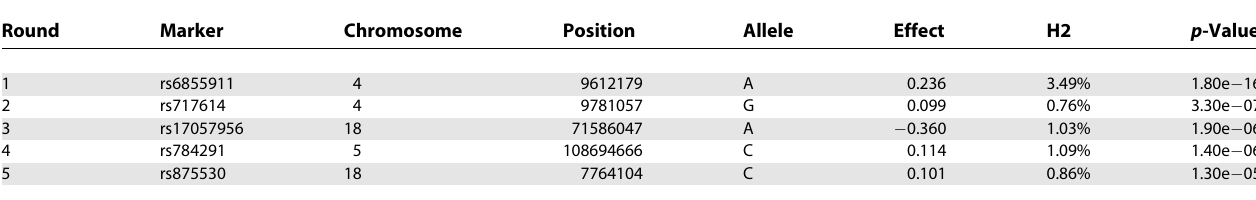
Table 2. Association Signals Identified in a Sequential Analysis Round